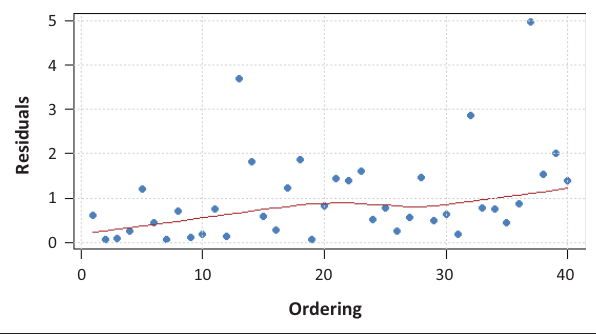
FIGURE 20: Kenya – Diagnostic plot for peak over threshold analysis: Scatterplot of the